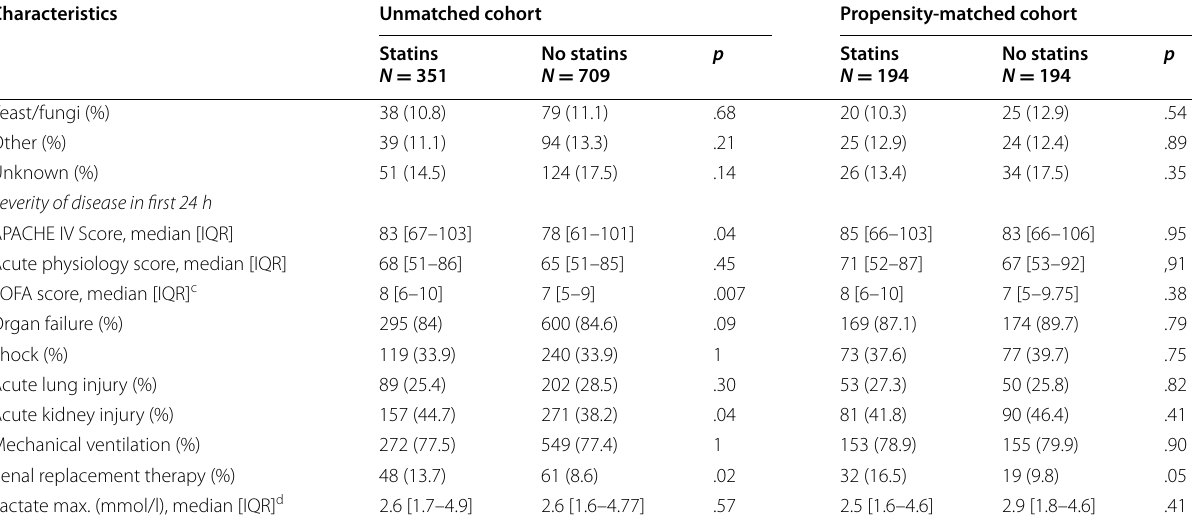
file 1: Table 1 for unmatched cohort; Figures 1–3 for matched cohort). Relative to healthy controls,